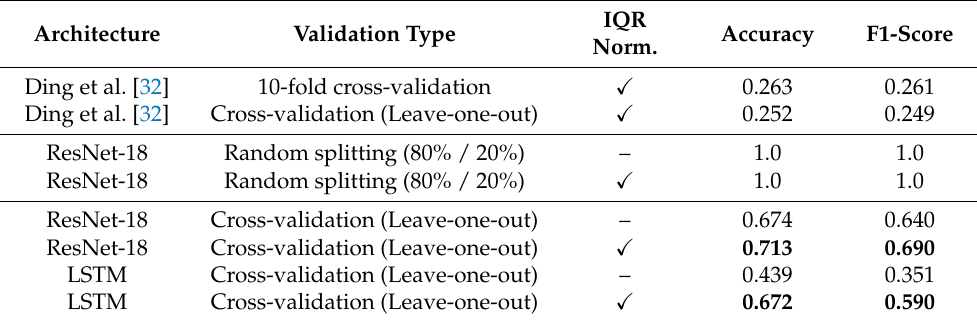
Table 4. Average classification performance for driving activity recognition on the RaDA dataset using a re-implementation of the Ensemble classifier ([32]), ResNet-18 & LSTM. Bold: best results.